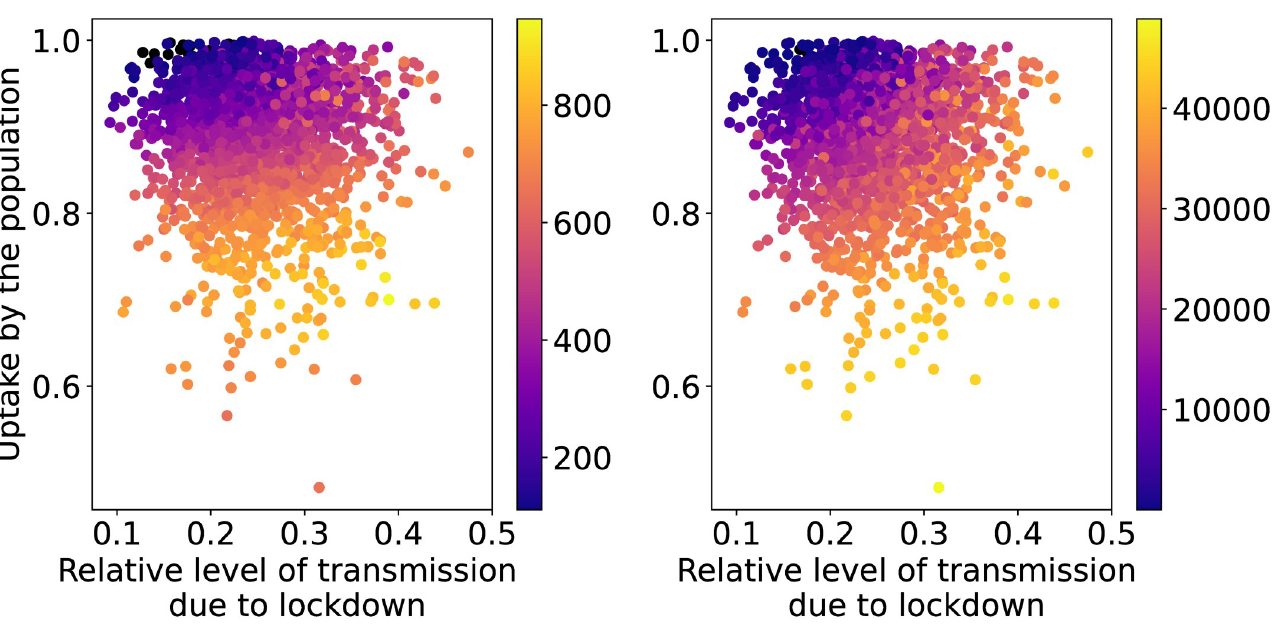
Fig 6. Heat map of the maximum values of patients in IC (left) and the total amount of IC patient-days in excess (right) per million capita as functions of the input parameters for the IL strategy with seed and policy-related uncertainties. The black dots show the simulations whose maximum value is below or equal to the IC capacity or there are no IC patient-days in